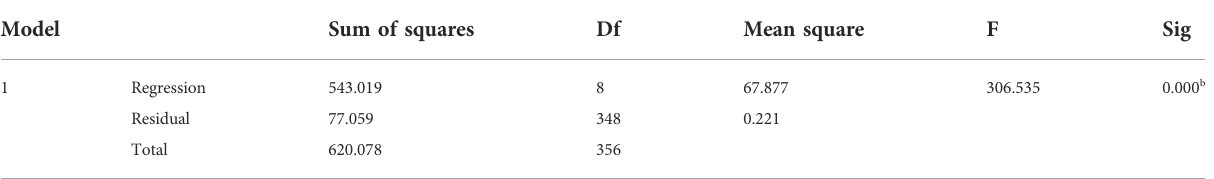
TABLE 5 Summary of ANOVA for GC-1 in the energy sector. ANOVA